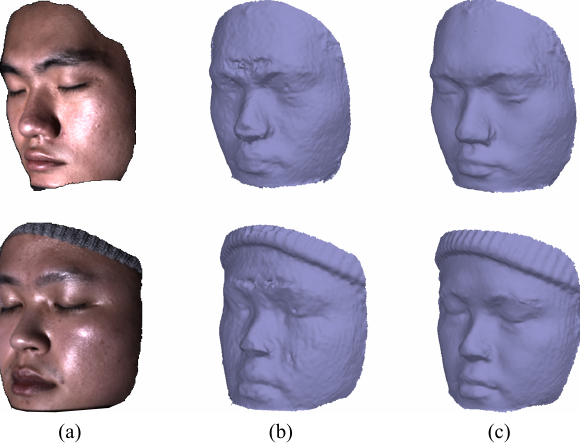
Figure 8. Improvement in the 3D face reconstruction. ( a ) A sample of input images. ( b ) Face reconstruction results obtained by highlight-contaminated facial images. ( c ) Face reconstruction results obtained by the highlight removal results of our method.